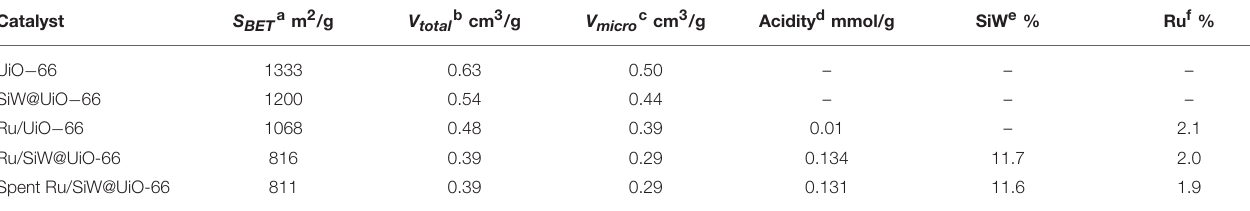
TABLE 1 | Physicochemical properties of various catalysts investigated in this study. Catalyst